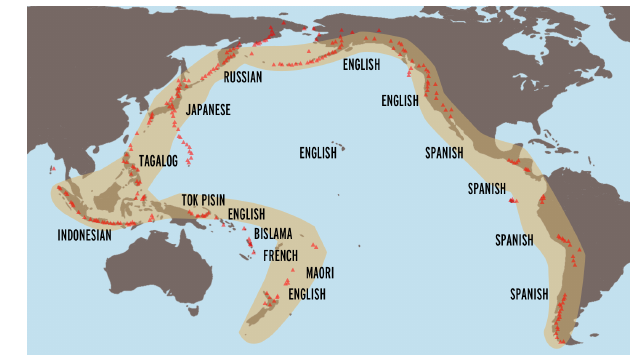
Figure 2. Map showing some of the major official languages spo- ken around the Ring of